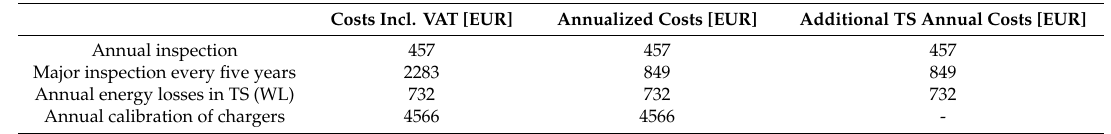
Table 3. Fixed operating